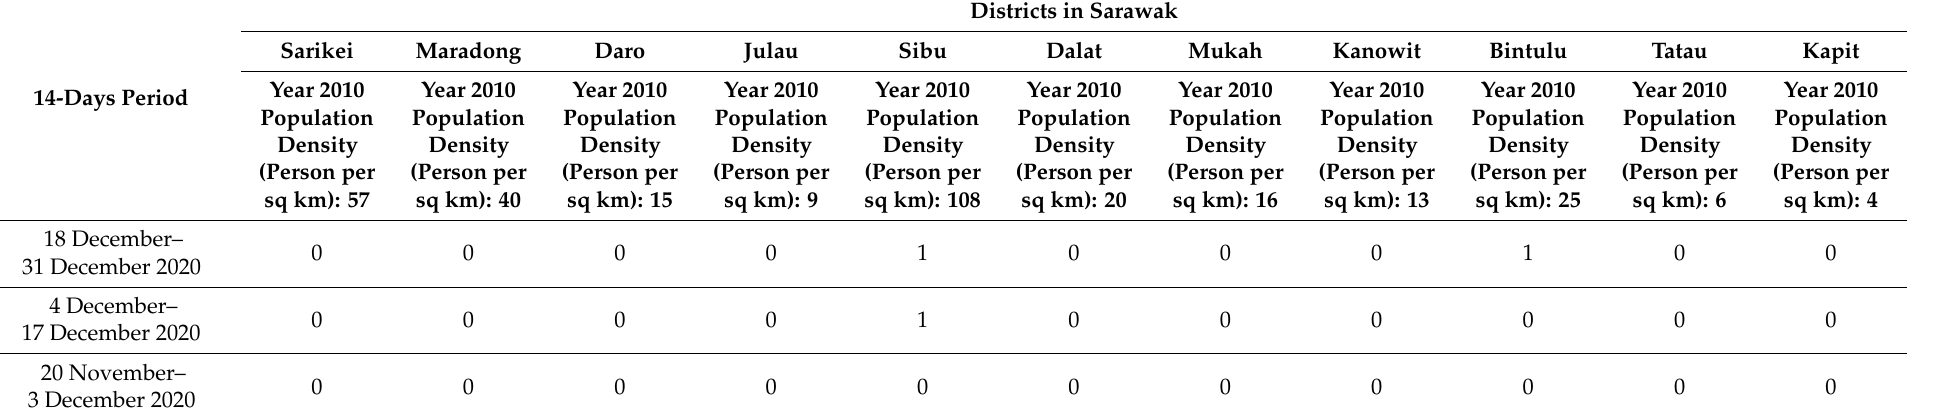
Table 4. COVID-19 cases from 25 January–21 December 2020 for 31 districts in the Sarawak State, Malaysia (Part 2)